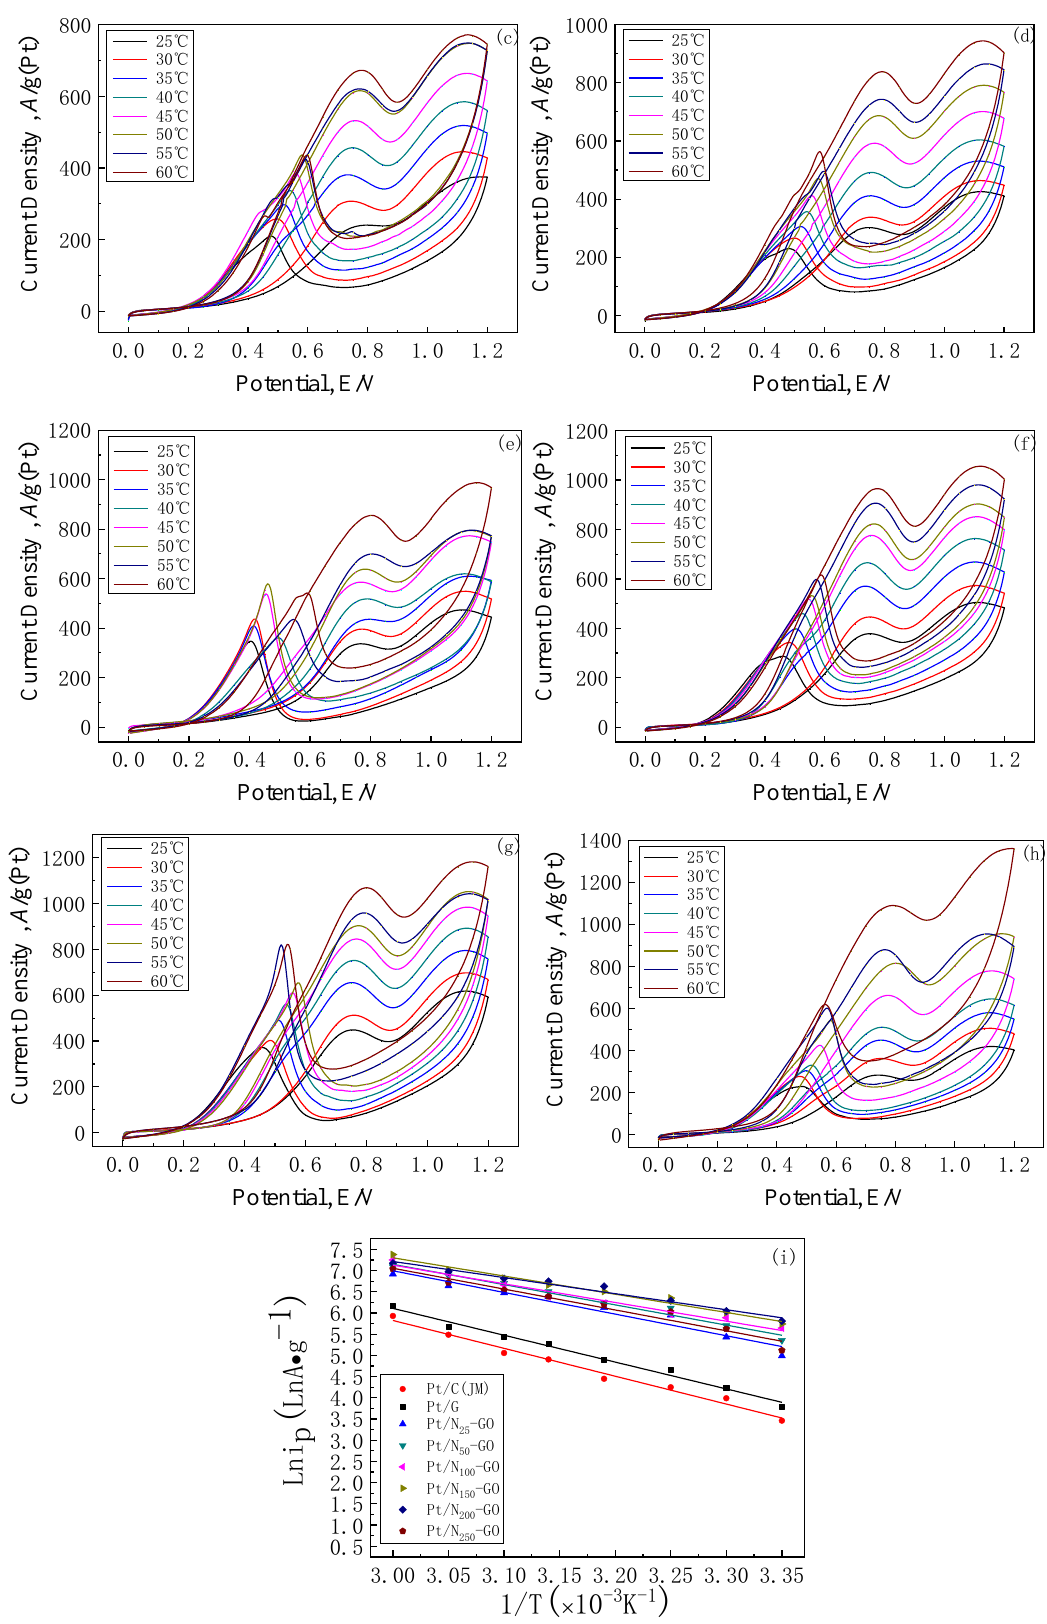
Figure 9. Variable-temperature cyclic voltammograms recorded for the catalysts: ( a ) Pt/C(JM), ( b ) Pt/GO, ( c ) Pt/N 25 -GO, ( d ) Pt/N 50 -GO, ( e ) Pt/N 100 -GO, ( f ) Pt/N 150 -GO, ( g ) Pt/N 200 -GO, ( h ) Pt/N 250 -GO; ( i ) Arrhenius curves of catalysts.